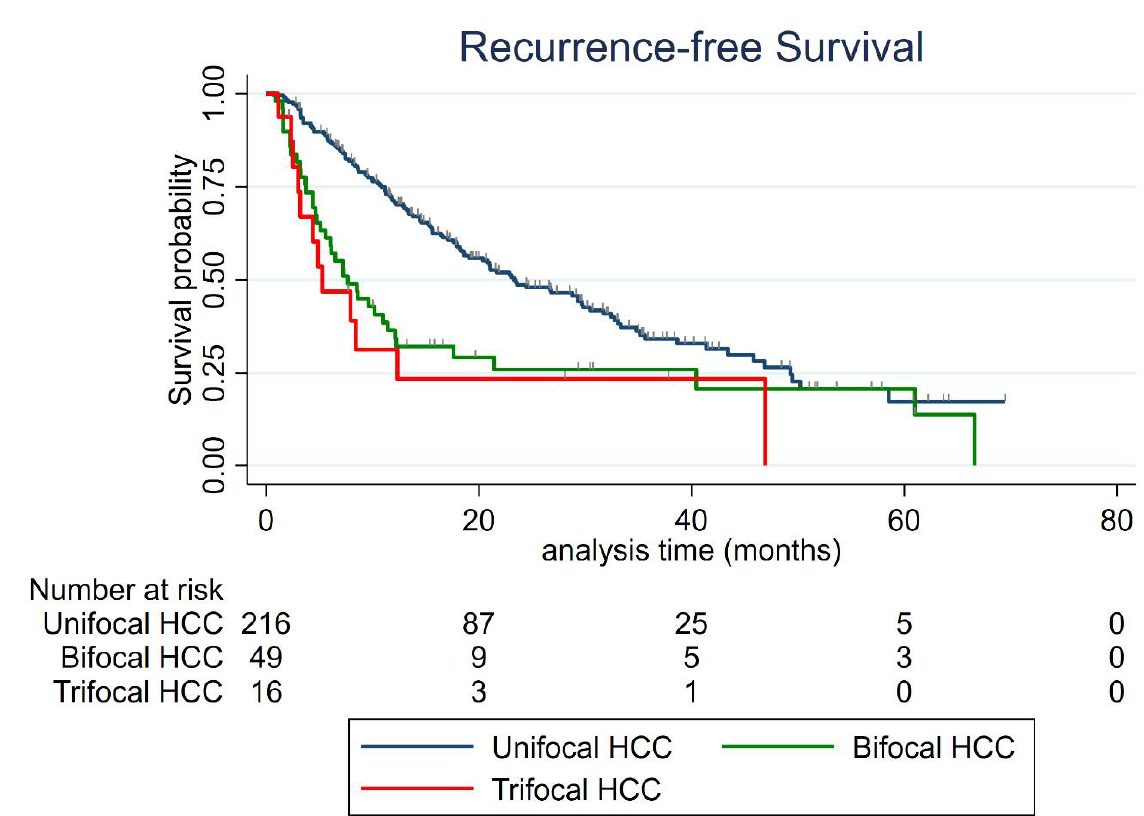
Figure 3. Recurrence-free survival according to the number of HCC nodules. The median OS was not reached for all groups, except for trifocal HCCs (30.3 months (95 CI:19.3-not reached)) (Figure 4). Factors associated with OS in uni- and multivariate analysis are listed in Table 6. Trifocal vs. unifocal HCC was independently associated with shorter OS (HR = 3.30 (95% CI: 1.37–8.02) p = 0.008), whereas bifocal vs. unifocal HCC was not (HR = 1.60 (95% CI: 0.69–3.72) p = 0.27). Naïve patient (HR = 0.42, p = 0.007), AFP > 100 ng/mL (HR = 3.03, p = 0.008), MELD > 9 (HR = 2.84, p = 0.001) and steatotic HCC (HR = 0.12, p = 0.038) were also found as independent predictors of overall survival. The predicting ability of the multivariate model was high (Harrel’s C index = 0.79). The results were internally validated using bootstrapping, except for those related to steatotic HCC. Table 6. Univariate and multivariate Cox regression models to predict OS (per patient Analysis).